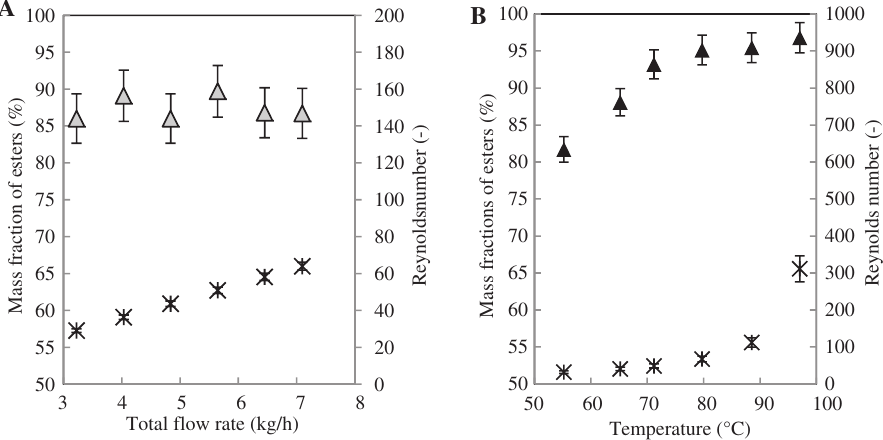
Figure 4 Influence of (A) flow rate at 55 ° C and (B) temperature at a fixed flow rate of 4.8 kg/h on the mass fraction of methyl ester. Mass fractions of esters (left y -axis) are represented with triangles and Reynolds numbers (right y -axis) with